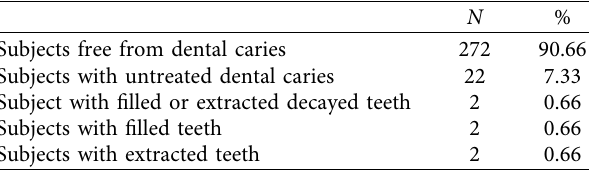
Table 2: Prevalence of dental caries.